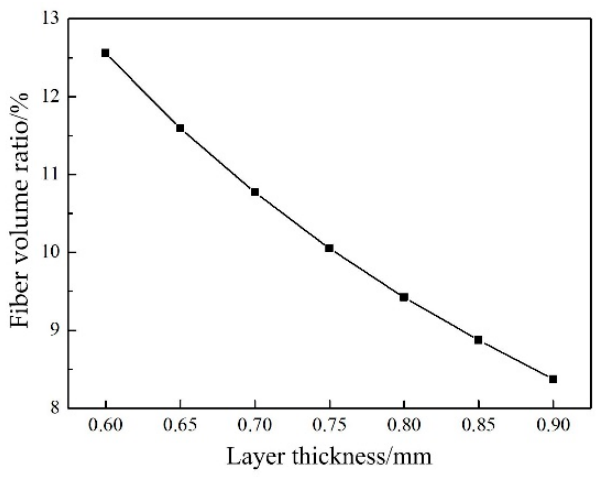
Figure 12. The fiber volume ratios of the three-layer entities prepared at different printing layer